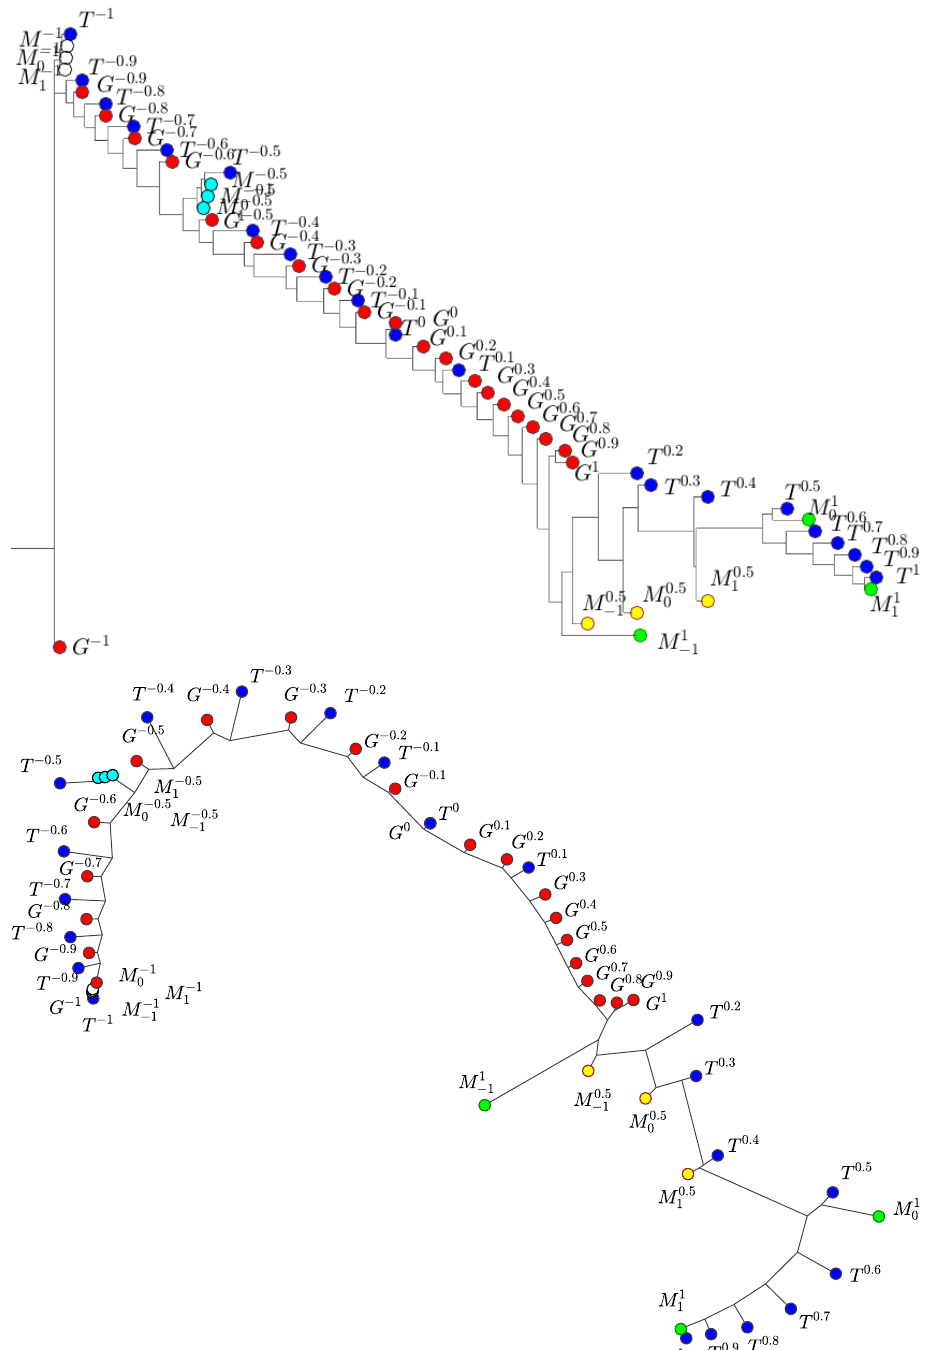
Figure 5. Dendrogram ( top ) and tree ( bottom ) representations of the N = 54 numerical series produced by the ArcCosine distance, d Ac , for r =